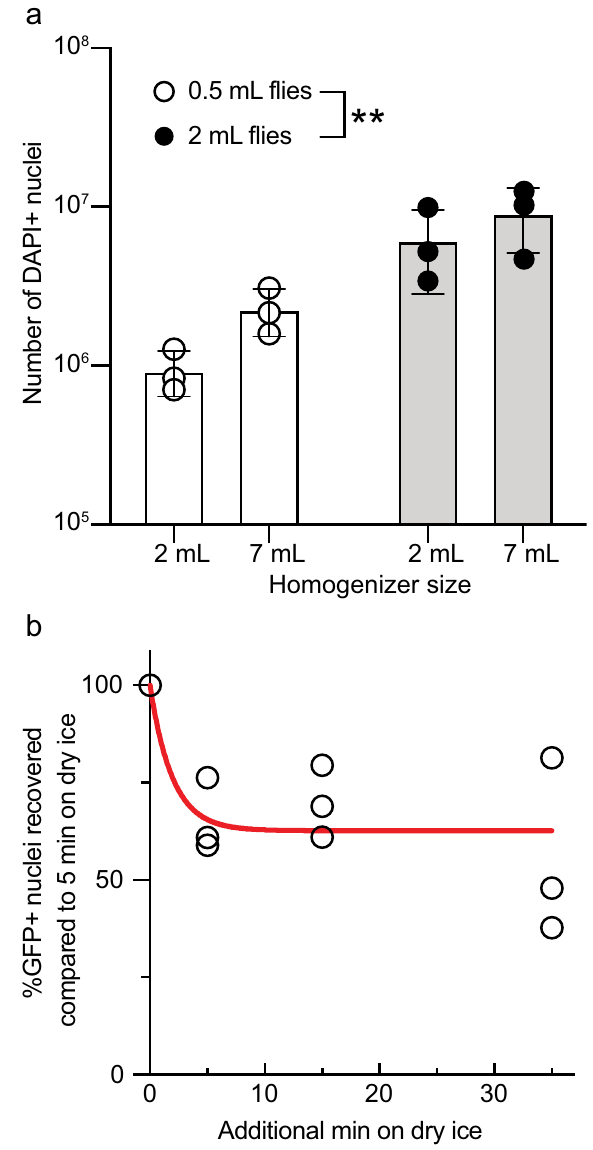
Figure 1. Sample volume and freezing time affect nuclei yield. ( a ) The number of flies used to collect heads prior to nuclei isolation increases the number of extracted nuclei, but the homogenizer size does not. The indicated volumes of w* Berlin flies were used for nuclei isolation. Data represent the mean ± SD of three independent experiments. ( b ) Freezing time longer than 5 min decreases GFP detection by flow cytometry. Flies expressing pan-neuronal GFP ( nSyb-Gal4 UAS-GFP-nls ) were counted at the low gate. Data represent three biological replicates. The data in ( a ) were analyzed by two-way ANOVA and the data in ( b ) were analyzed by nonlinear regression using one-phase exponential decay, K = 0.51 min −1 , goodness of fit R 2 = 0.64. ** p <